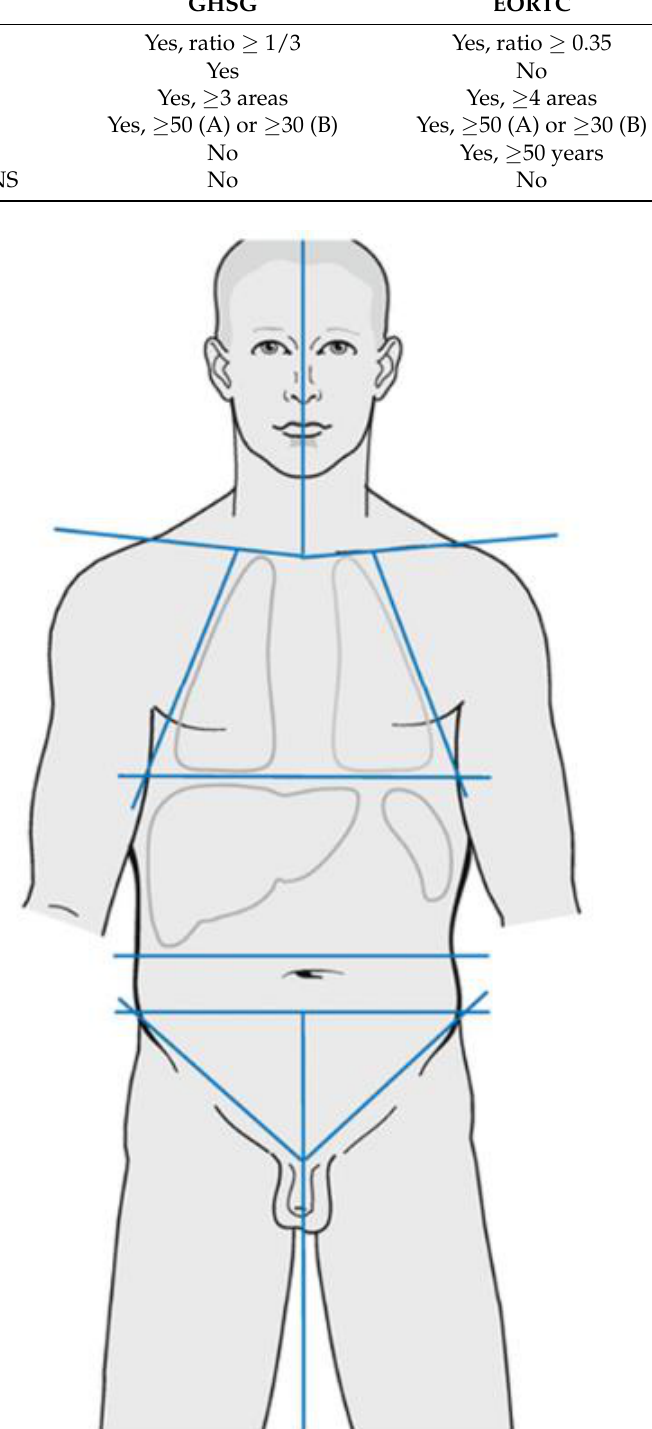
Figure 1. Lymph node sites as defined by the GHSG (https://en.ghsg.org/disease-stages, accessed on 3 October 2022), image taken from the BSH Guidelines for HL management [8].